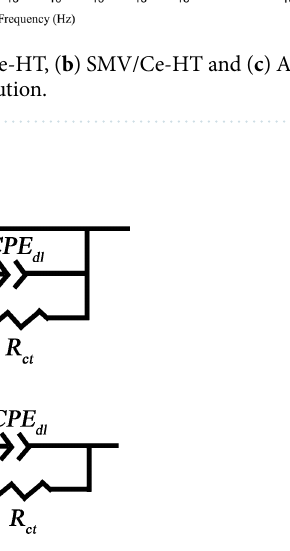
Figure 14. Equivalent circuits used to fit the EIS spectra.